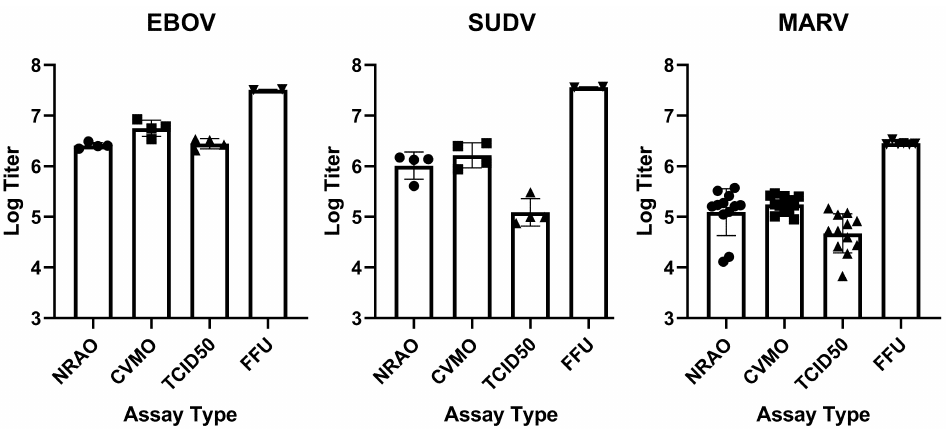
Figure 6. Titer comparison for the three Filoviruses in each assay. Assays were completed in EBOV (left), SUDV (middle) and MARV (right). Virus titers were determined by each assay type and compared. For NRAO and CVMO assays, titer is PFU/mL. For TCID 50 the assay end point was determined using the Reed–Muench method to calculate when 50% of wells would show complete cytopathology. FFU is calculated from the number of infected cell foci to give FFU/mL. Mean value with standard deviation is shown. Replicates ( n ) shown: MARV n = 12 (NRAO, CVMO, TCID 50 ), n = 6 (FFU). EBOV, SUDV n = 4 (NRAO, CVMO, TCID 50 ), n = 2 (FFU). Symbols (•) = NRAO assay replicate, ( ■) = CVMO assay replicate, (▲) = TCID50 assay replicate, (▼) = FFU assay replicate. Table 2. Titer Comparison between Assays for 3 Filoviruses. Titer differences are shown in Log10- Fold difference. Turkey’s Multiple Comparison test was used to determine significance of differ- ence between titers of each assay, per virus. Statistical significance was set at p < 0.05.